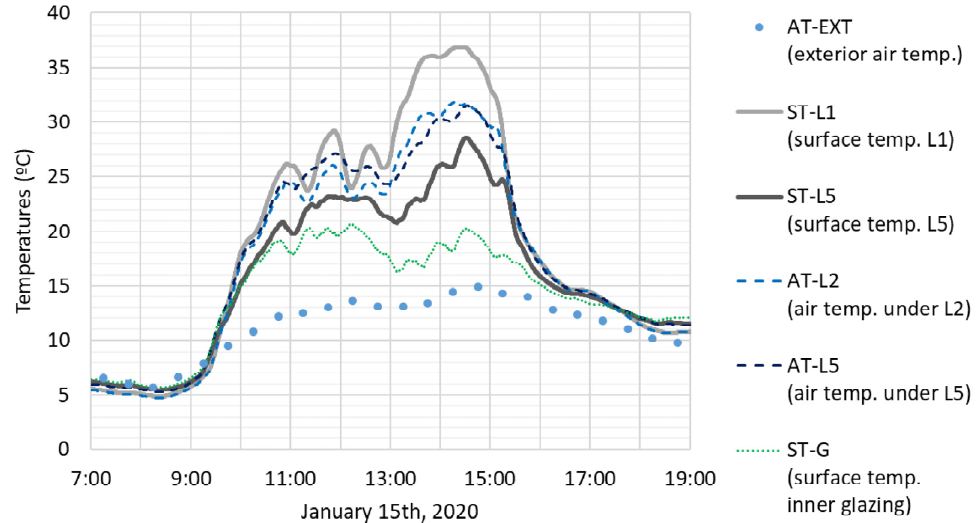
Figure 5. Temperatures in the model during the selected day in cold outdoor temperature condi- tions.